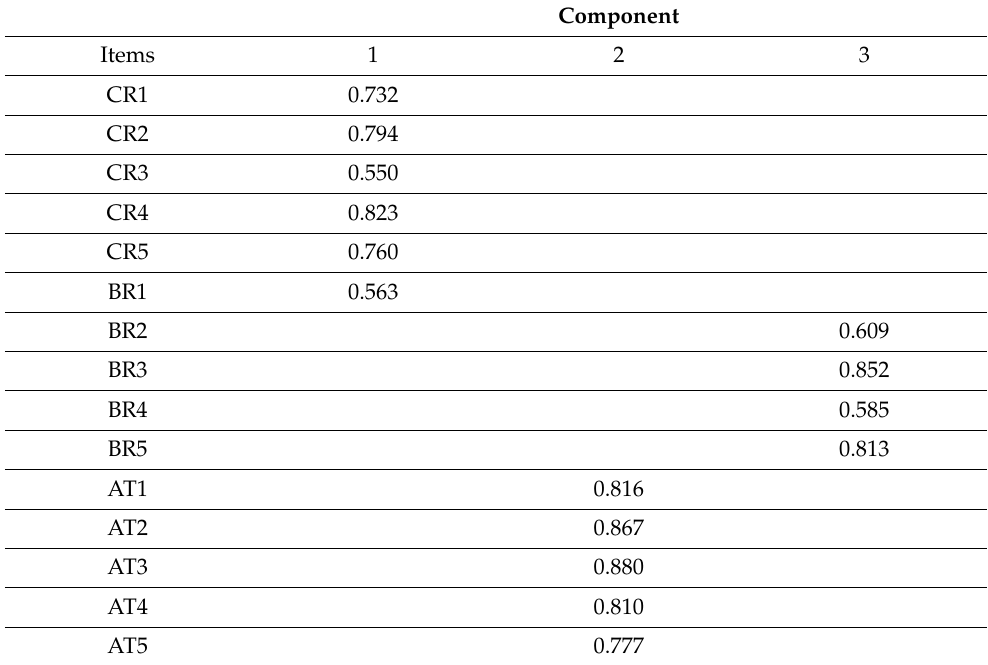
Table 2. Rotated component